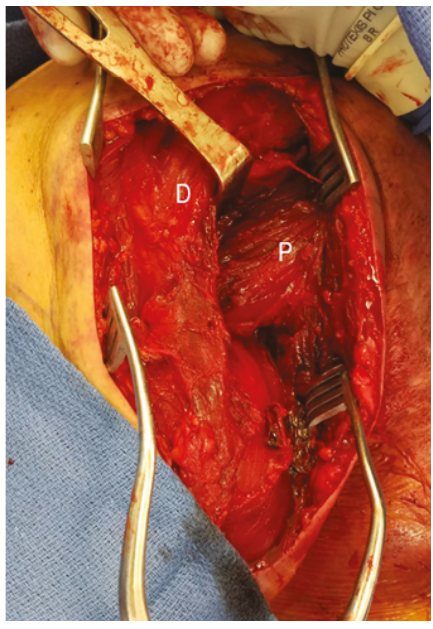
Figure 8: D: deltoid; P: repaired pectoralis major.